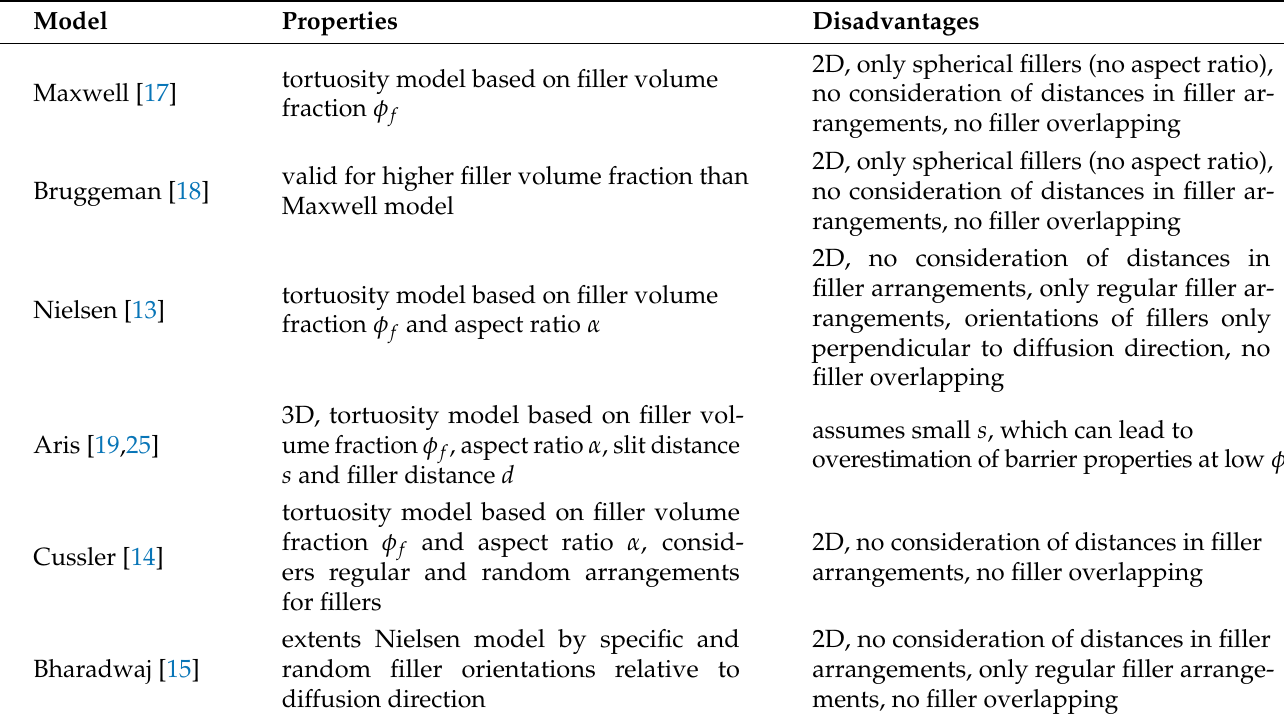
Table 1. Exemplary overview of common analytical permeation models. This overview of the models is a summary based on the information in [11,12,25–27]